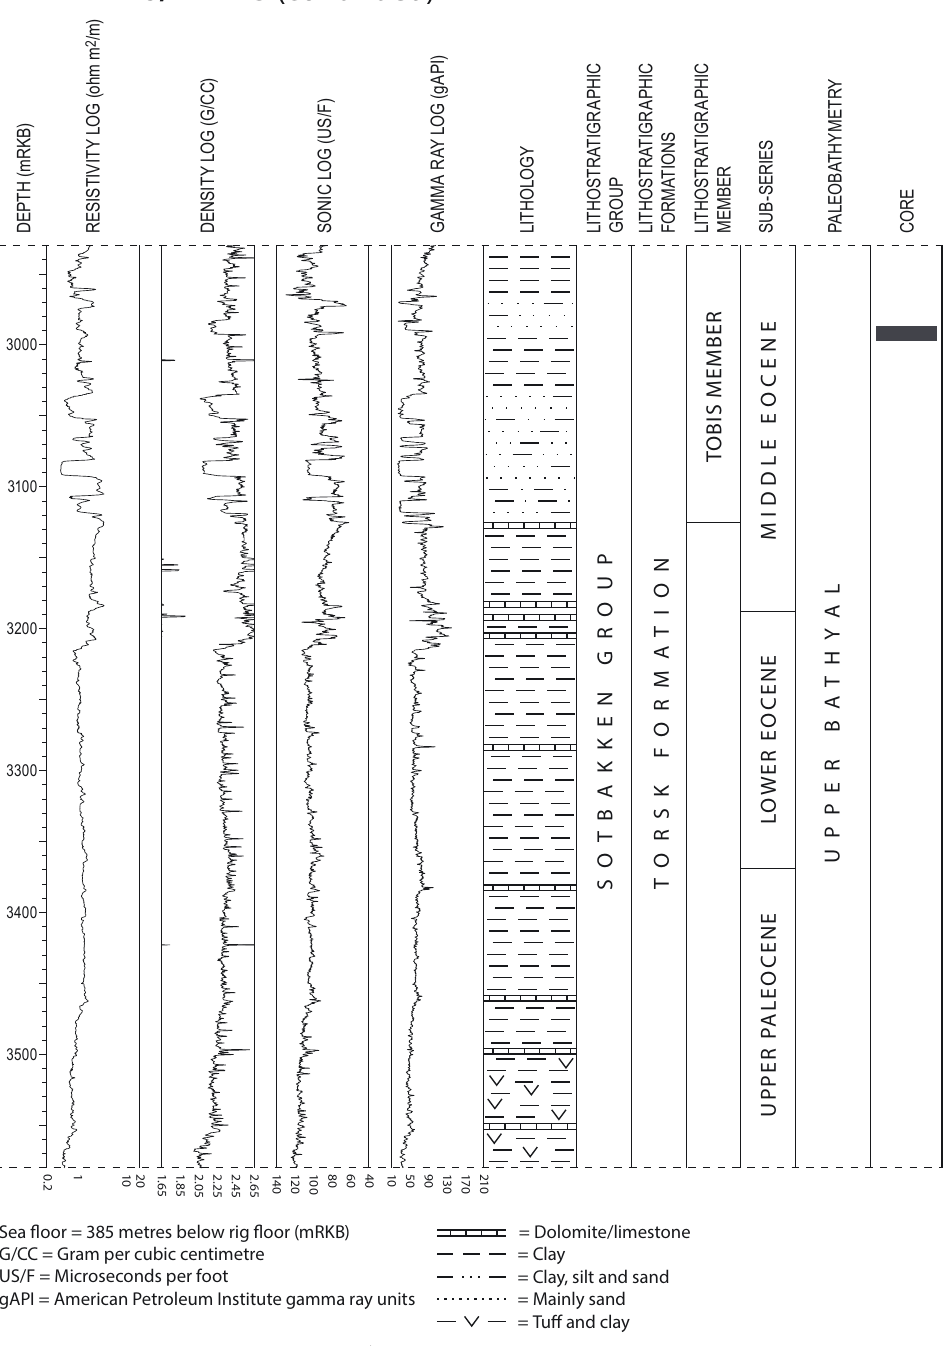
Figure 9. Well summary figure for well 7216/11–1 S including resistivity log, density log, sonic log, gamma-ray log, lithology, lithostratigraphic units, sub-series, paleobathymetry and core for the middle part of the supplementary well reference sections for the Torsk Formation and the lower part of the type section for the Tobis Member (upper Paleocene to middle Eocene; modified after Ryseth et al., 2003;